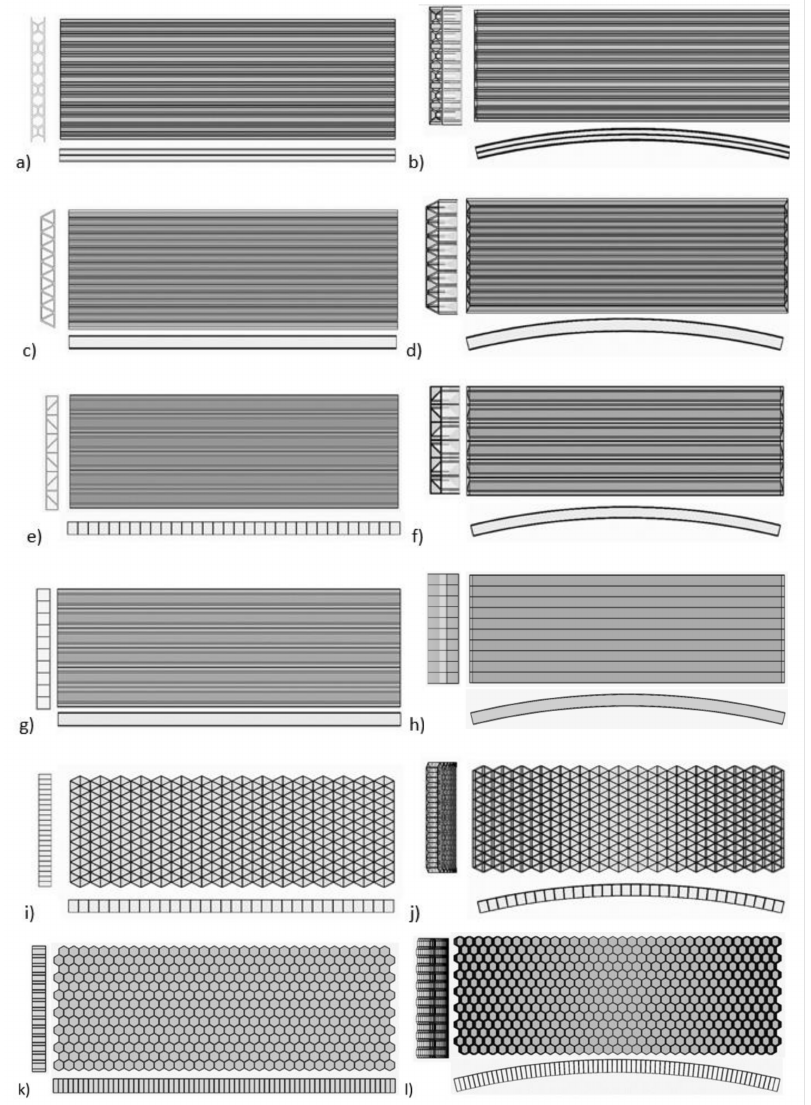
Figure 3. GFRP plate, adhesively bonded pultruded profiles: ( a ) Superdeck; ( b ) Superdeck in an arch; ( c ) EZSpan; ( d ) EZSpan in an arch; ( e ) DuraSpan; ( f ) DuraSpan in an arch; ( g ) Strongwell; ( h ) Strongwell in an arch. Sandwich panels: ( i ) triangular-shaped infill; ( j ) triangular-shaped infill in an arch; ( k ) honeycomb-shaped infill; ( l ) honeycomb-shaped infill in an